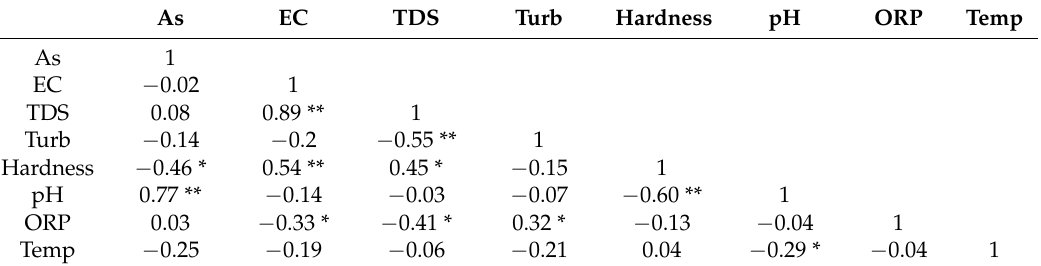
Table 4. Pearson correlation among the PhP in the wells of the ID005, sampling 2